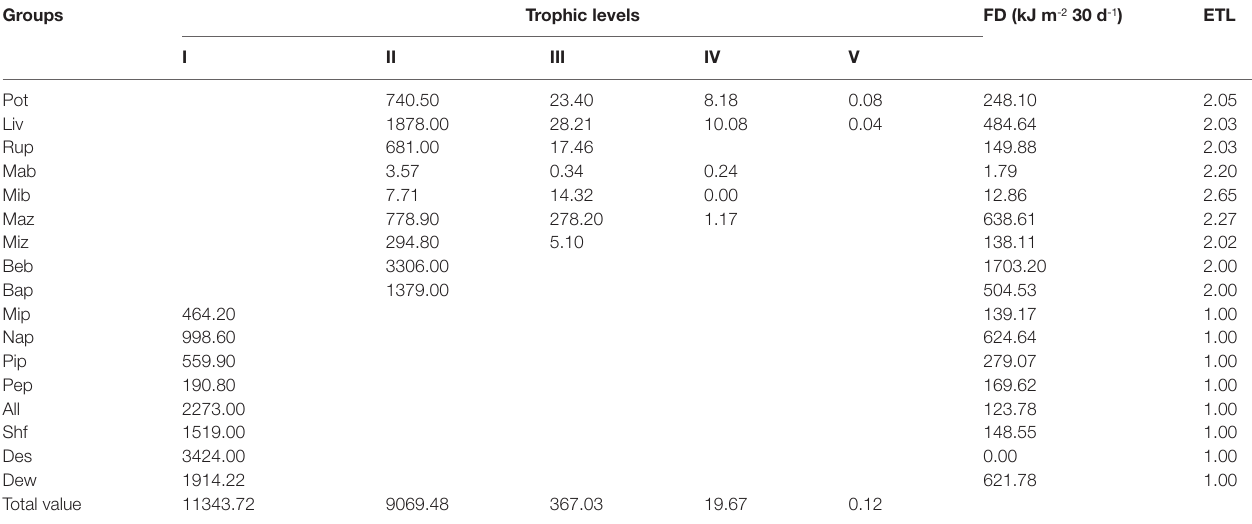
TABLE 7 | Absolute flows of each group by trophic level decomposition of a Portunus trituberculatus polyculture ecosystem during the middle period.